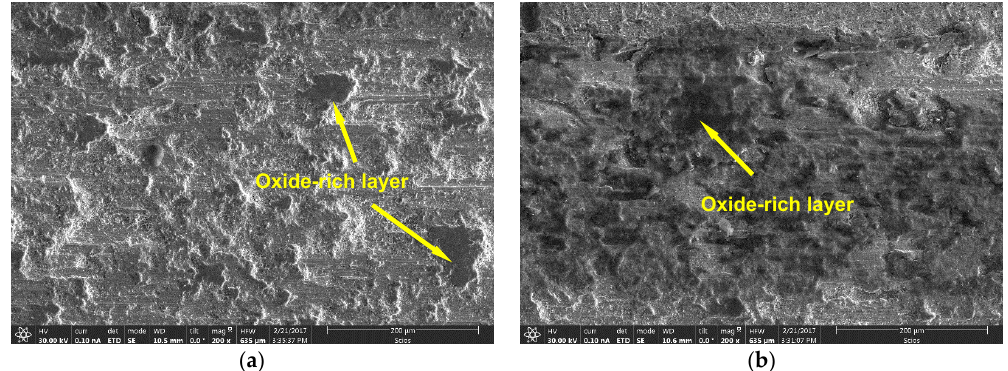
Figure 11. Scanning electron microscopy ( SEM) images of the wear track generated on the surface of the UNSM-treated at RT ( a ) and LHT with UNSM treatment at HT of 1000 °C ( b ) specimens.